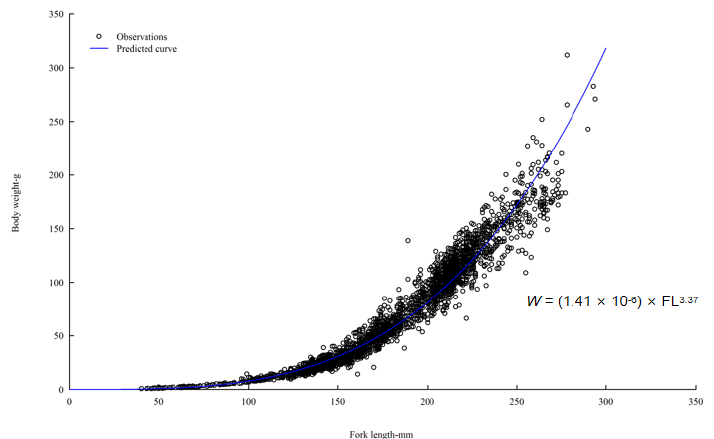
Figure 4. Fork length–weight relationship of Chub mackerel specimens collected from waters off Figure 4. Fork Length-weight relationship of Chub mackerel specimens collected from waters off the the northwest Pacific Ocean . northwest Pacific